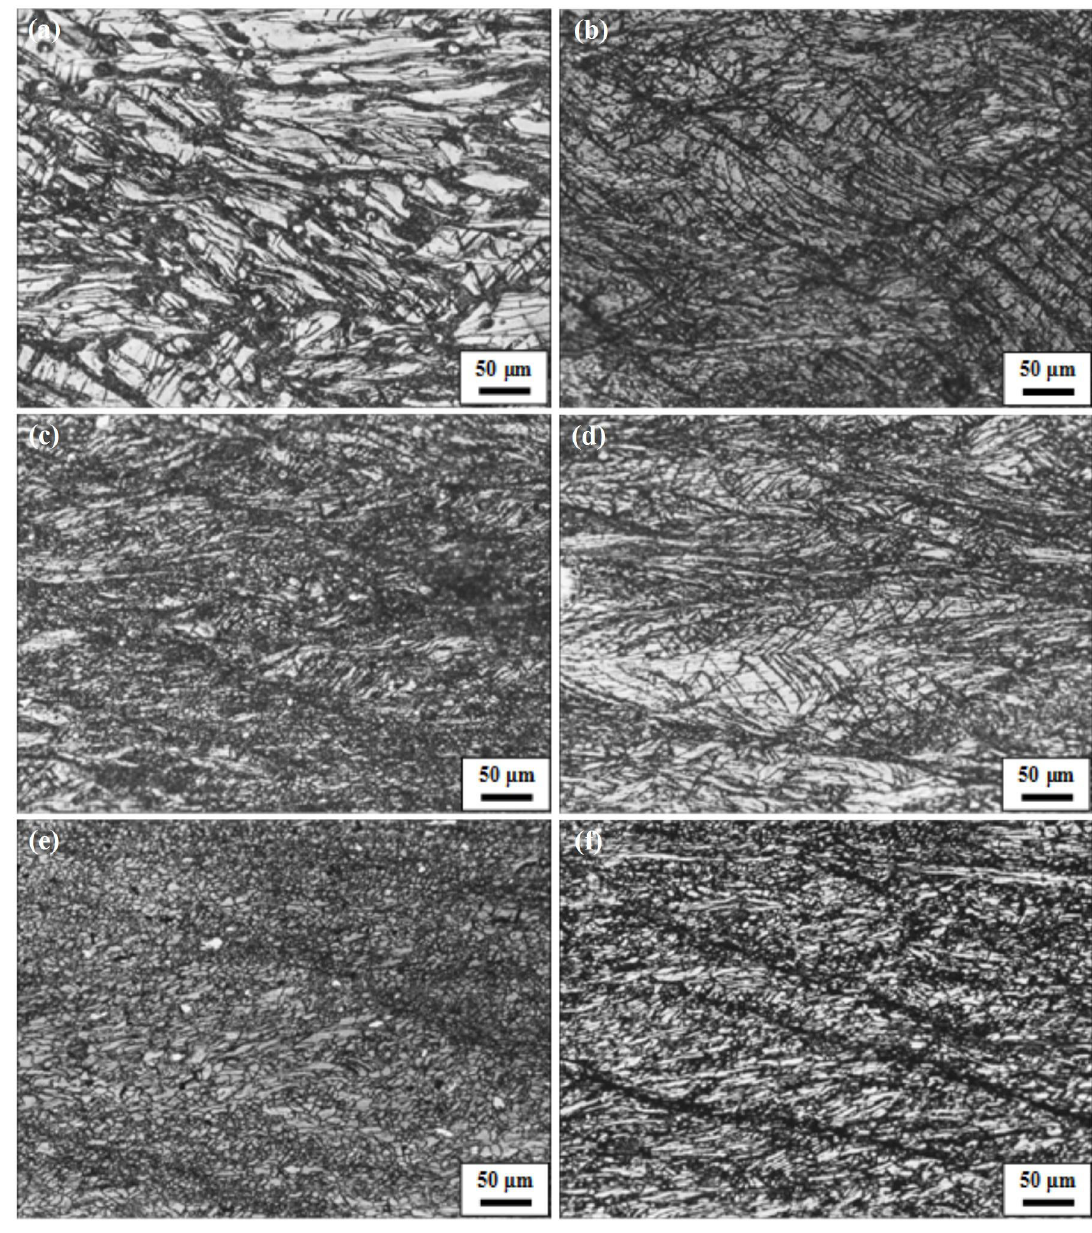
Fig. 3. Typical microstructure of Mg-4.5Al-1.0Zn after AR at 300 °C after (a, b) 43%, (c, d) 68%, and (e, f) 75% rolling reductions by (a, c, e) from ingot and (b, d, f) from TRC, respectively. Longitudinal sections with RD parallel to scale